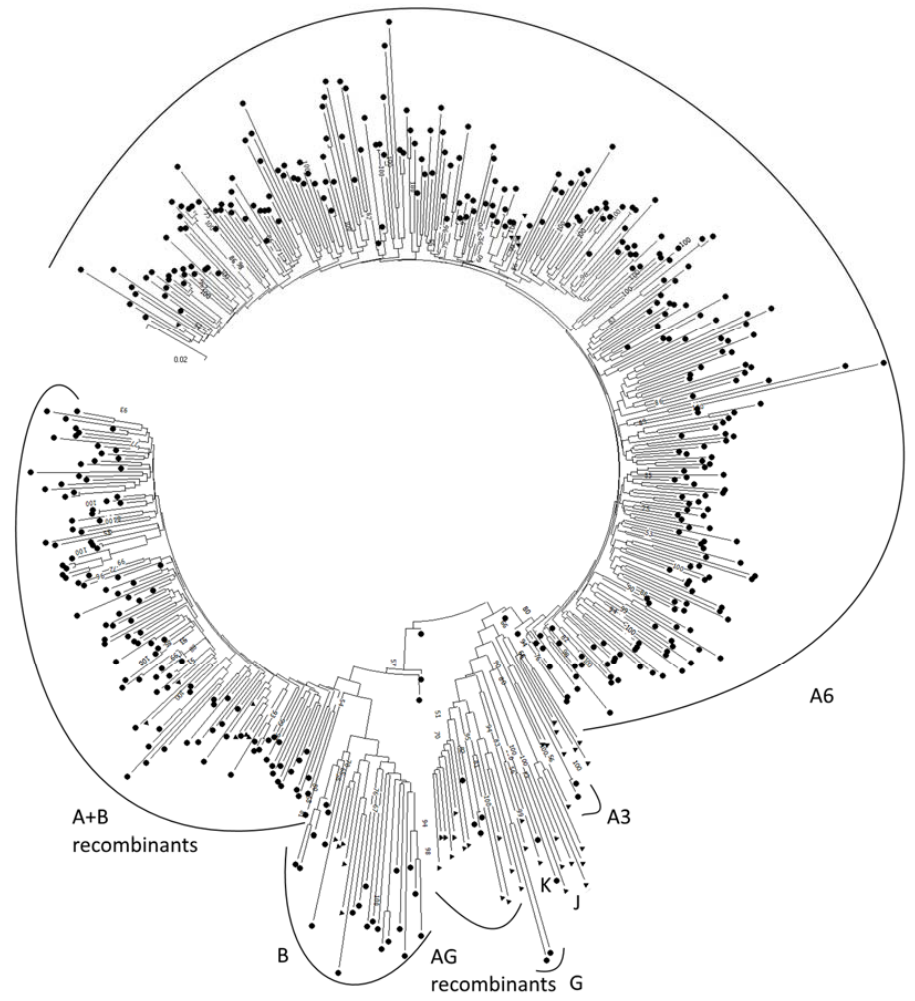
Figure 1. Result of phylogenetic analysis using Mega X. Key: ▲ reference sequences from GenBank; ● sequences of isolates from this study. Numbers on the nodes are bootstrap support values.